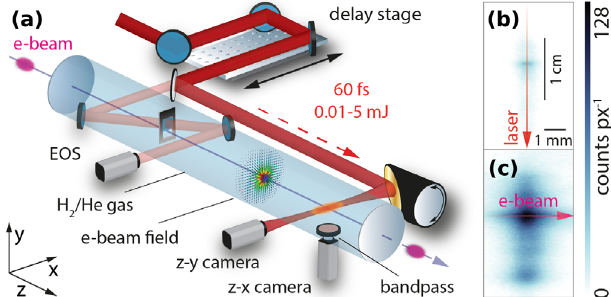
FIG. 1. Experimental setup and afterglow shots: (a) The elec- tron beam propagates through gas and couples with an over- lapping laser-generated seed plasma. (b) Example of laser-only plasma afterglow at 587 nm. (c) Example of electron-beam- enhanced plasma